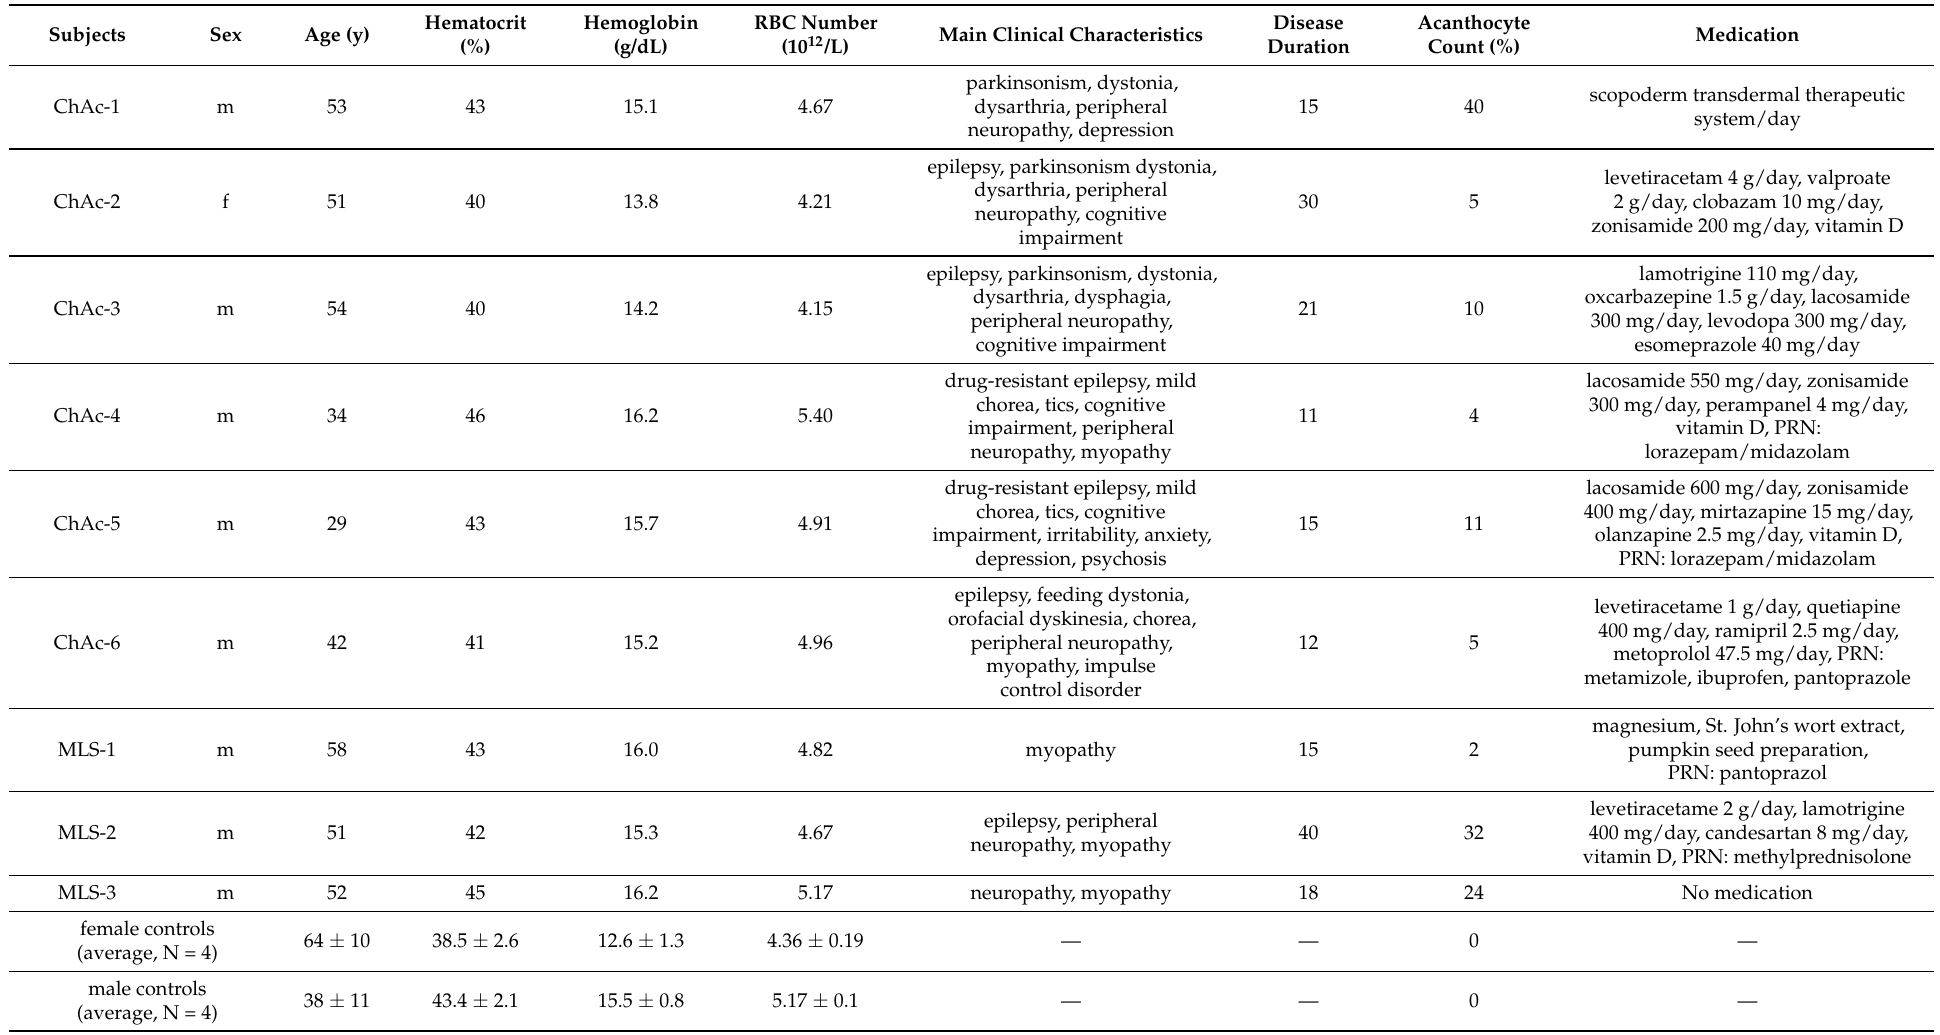
Table 1. Overview of the patients and